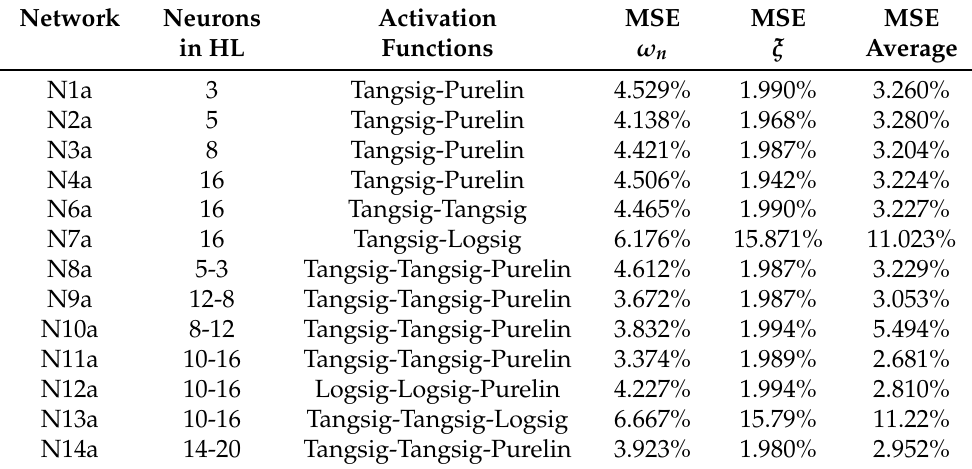
Table 3. Relevant tests for determining the architecture of ANNs for critical damped, overdamped, and heavily overdamped